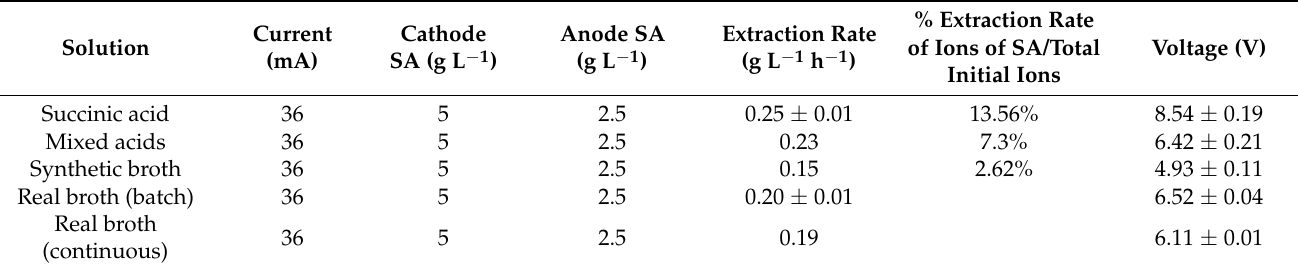
Table 5. Comparison of succinic acid extraction rate and voltage requirement of all experiments at a fixed current of 36 mA. The initial concentration of succinic acid (SA) in all solutions was of 5 g L − 1 . The measured variables are extraction rate of succinic acid and